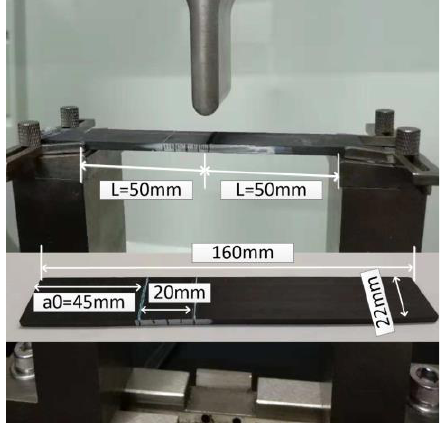
Figure A1. Detailed experiments and sample settings. The test samples measured at different ambient temperatures are shown in Appen- dix Figure A2. The force/displacement curves measured at different ambient tempera- G IIC :